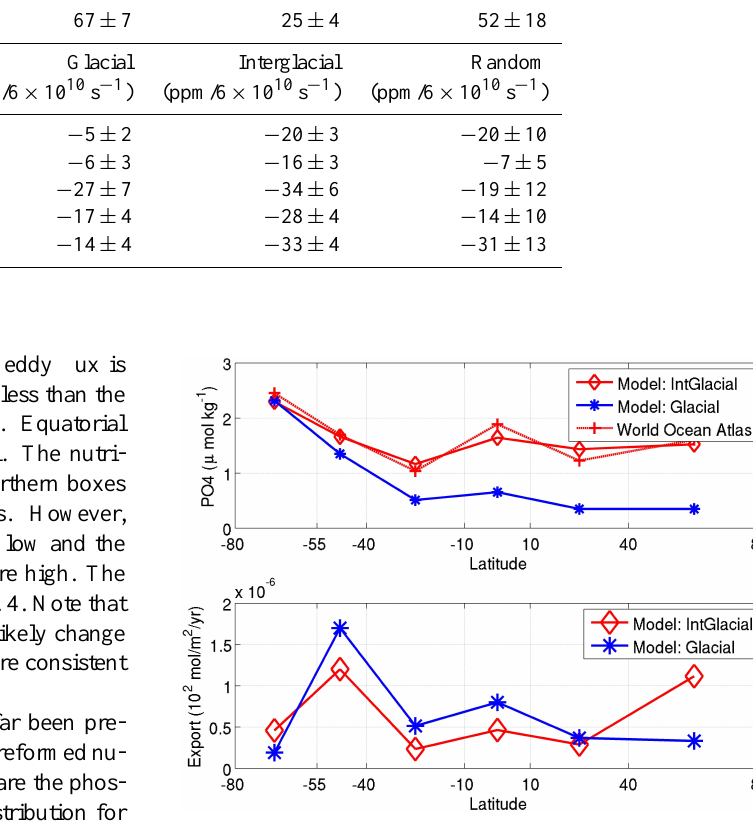
Fig. 4. The average surface nutrient concentrations (top) for the 300 interglacial states (solid red lines and diamonds) and the 300 glacial states (solid blue lines and stars). Also shown for refer- ence is the observed modern nutrient distribution (dashed red lines and crosses). Export production (bottom) from each surface box for the interglacial and glacial states. The modern nutrient distribution were obtained from the World Ocean Atlas (Garcia et al.,